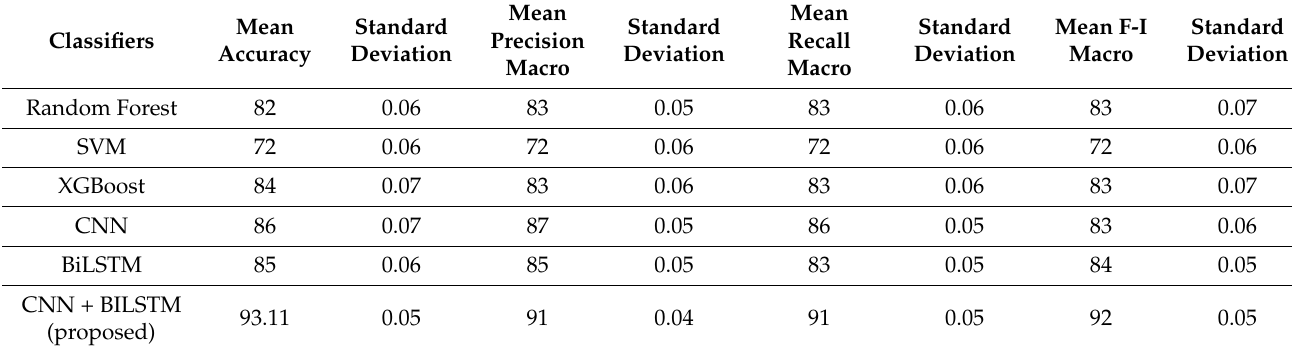
Table 11. Cross validation of the proposed system contrasted with different classifiers.